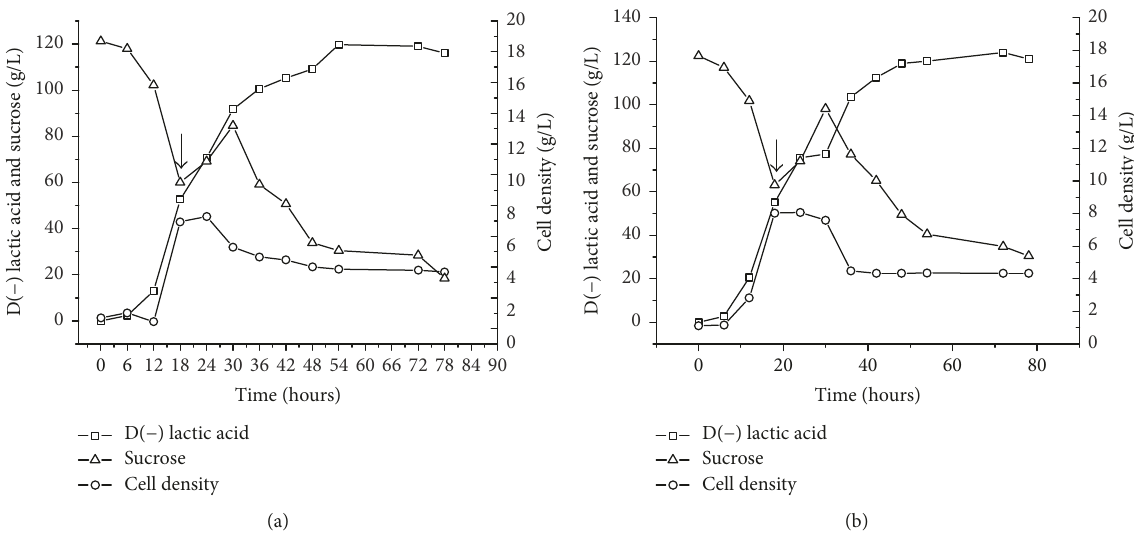
Figure 6: Time courses of sucrose consumption, D( − ) lactic acid production, and cell growth in constant feed rate (a) and exponential fed- batch fermentation (b) by S. nakayamae . Experimental conditions: medium containing 35 g/L of yeast extract and 7.5mL/L of GYP salts and crystallized sugar (as required); pH 6.0, NaOH 10N as controlling agent, temperature at 35 ∘ C, 125 rpm, and 20% of inoculum (v/v).